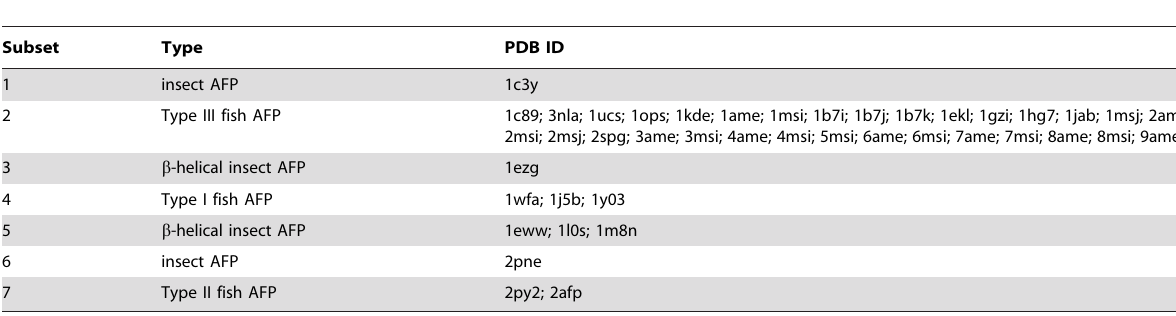
Table 1. The seven AFP subsets used for cross-validation